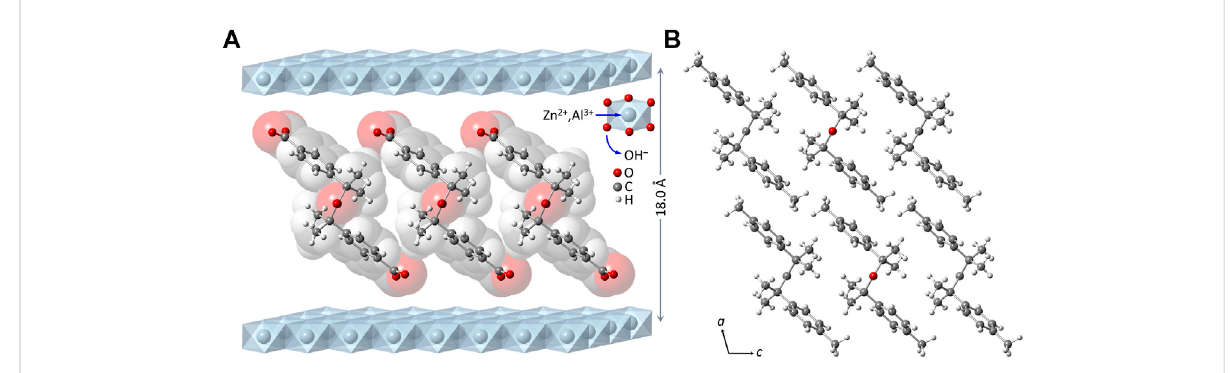
FIGURE 2 (A) Structural model (ball-and-stick diagram superimposed on a space fi lling, van der Waals-based representation) for the monolayer arrangement of 4,4 ′ -(2,4-dimethyl-3-oxopentane-2,4-diyl)dibenzoate anions in the material LDH-KDA3. (B) View of the crystal packing of 2 down the crystallographic b axis.